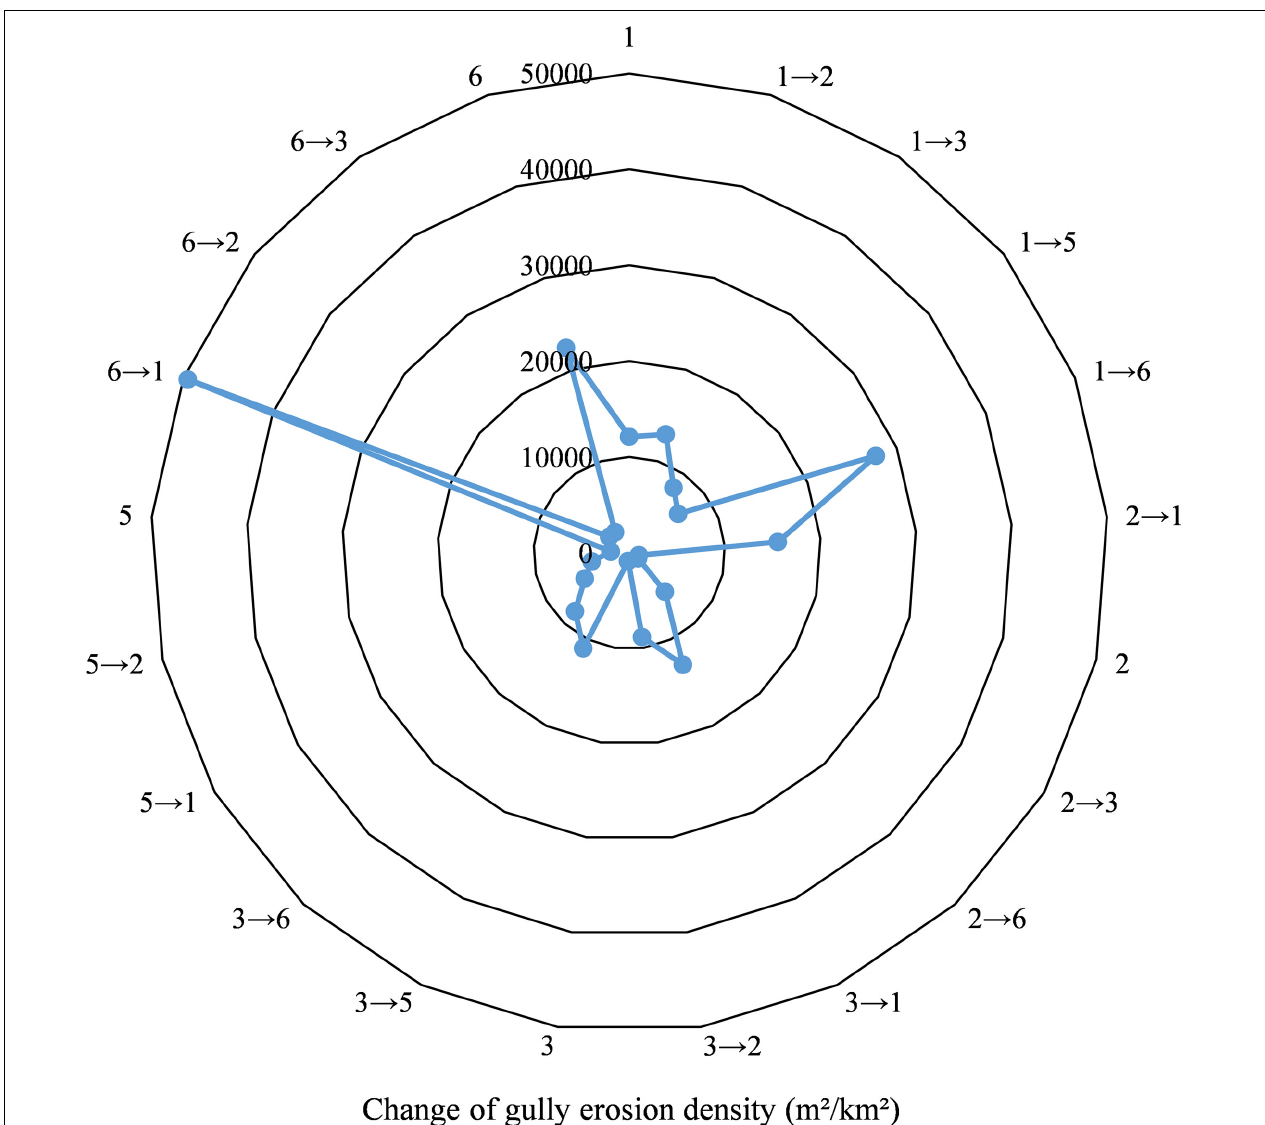
FIGURE 9 | Change of erosion gully density caused by conversion of land use types from 1965 to 2015. Key: 1 cultivated land, 2 forestland, 3 wetland, 5 construction land, 6 other/degraded, 1 → 2 represents the conversion from cultivated land to forestland, and remaining